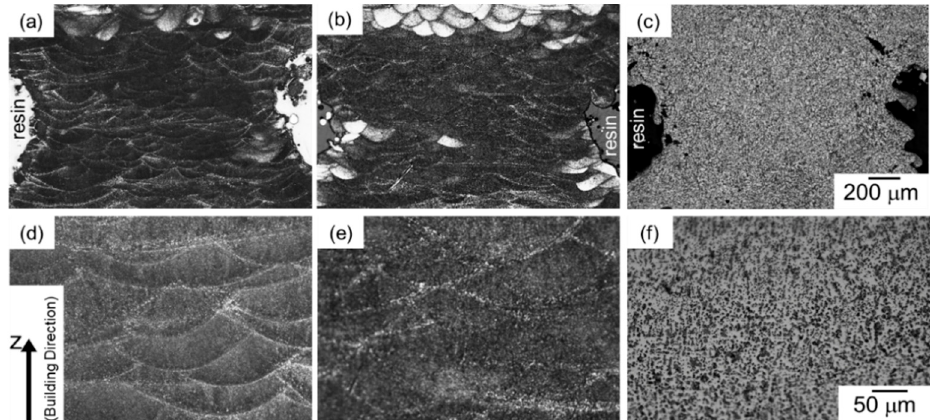
Figure 2. Optical micrographs of microstructures taken from the node portion of the lattice specimen at ( a – c ) low magnification and ( d – f ) high magnification: ( a , d ) as-manufactured, ( b , e ) annealed at 300 ◦ C for 2 h, and ( c , f ) solution heat treated at 530 ◦ C for 6 h.